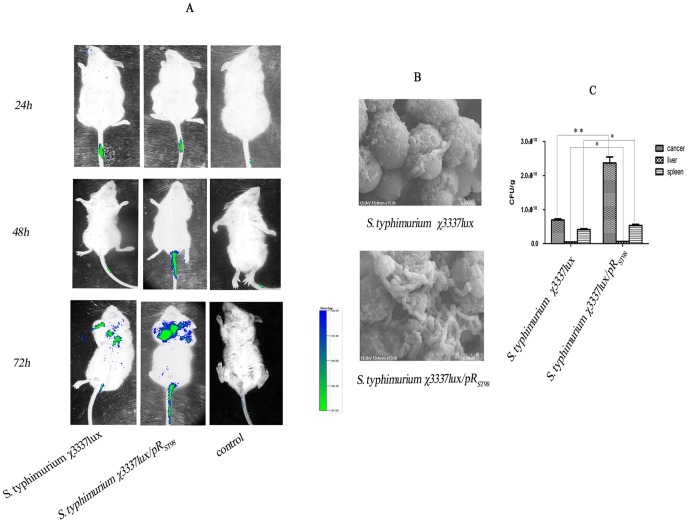
Bacterial accumulation at the indicated time points and the bacterial load in the organs of CT26 tumor mice.(A) Tumor-bearing mice were infected with 1×107 CFU of S. Typhimurium χ3337lux and χ3337lux/pRST98. The bioluminescence signals were captured by IVIS at the indicated time points. (B) Comparison of χ3337lux and χ3337lux/pRST98 accumulated in tumors at 3 d p.i. by SEM. (C) CFU counts of tumors, livers and spleens infected by χ3337lux or χ3337lux/pRST98. (**p <0.01); (*p <0.05)